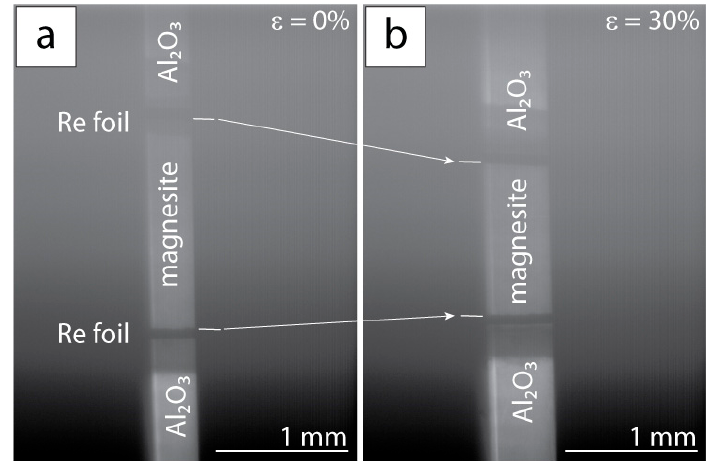
Figure 3. Radiographs of samples collected in-situ were used to determine strain and strain rate during all experiments (MAG_012, T = 900 °C, P eff = 5.8 GPa, ε(cid:4662) = 3.3 × 10 − 5 s − 1 , σ diff = 1.6 GPa, ( a ) prior to deformation and ( b ) at ε = 30%). Measurements of sample length were collected from the interface between the magnesite cylinder and Re foils (dark lines, measurement location highlighted by white line). The darker grey area in the Al 2 O 3 pistons is where the Pt jacket overlaps the Al 2 O 3 pistons. The black areas to the sides of the load column are caused by the WC anvils that absorb X-rays and partially block the view of the magnesite cylinder and Al 2 O 3 pistons, which are transparent to X-rays.